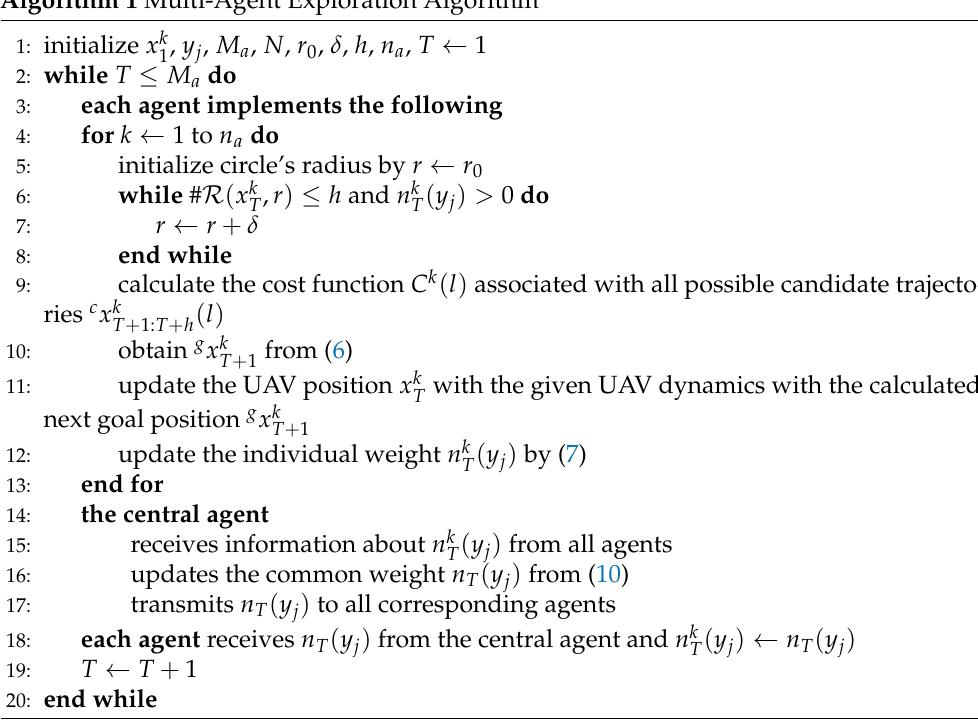
Algorithm 1 Multi-Agent Exploration